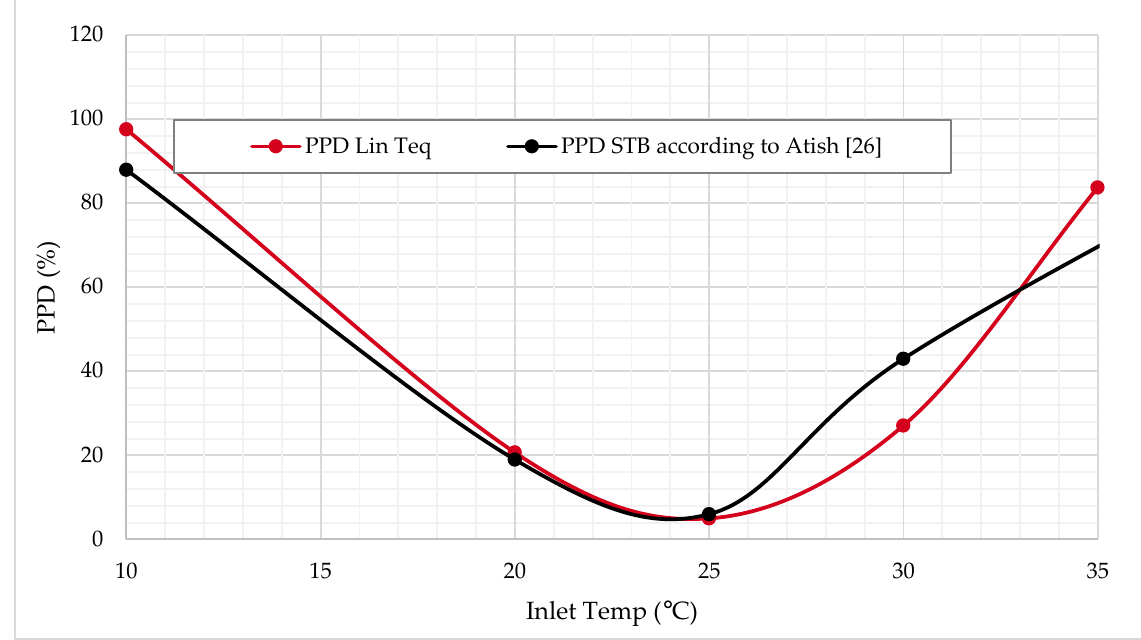
Figure 11. PPD in the cubic room.